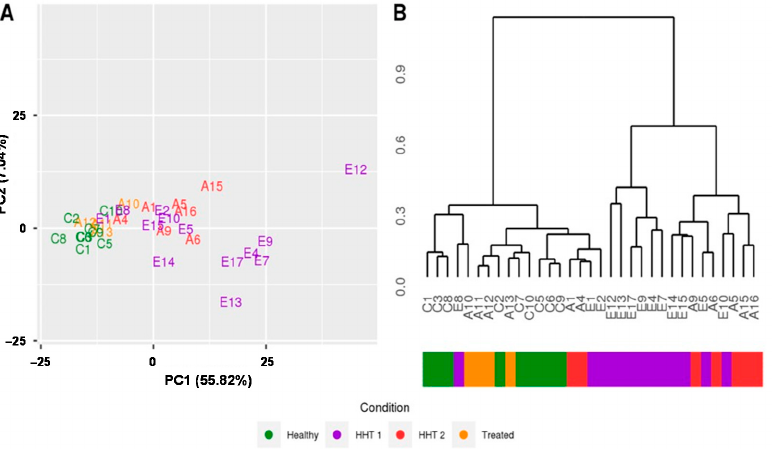
Figure 2. Comparison of HHT and healthy samples from miRNA gene expression signatures. ( A ) Principal component analysis and ( B ) hierarchical clustering analysis show that global gene expres- sion signatures are grouped into two main clusters, one containing healthy (green) and treated pa- tients (yellow) and the other containing most of the disease samples from HHT1 (purple) and HHT2 (red) subtypes.